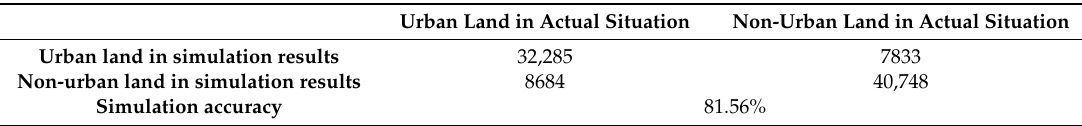
Table 8. Simulation accuracy results of PSO-CA algorithm in error matrix